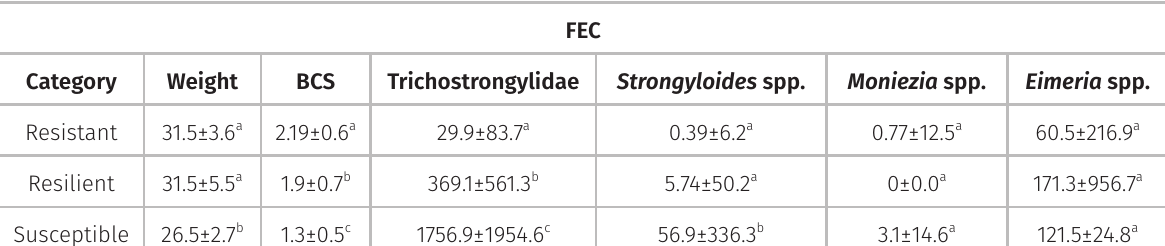
Table I. Means and standard deviations of weight, BCS and fecal egg count (FEC) of Morada Nova sheep according to